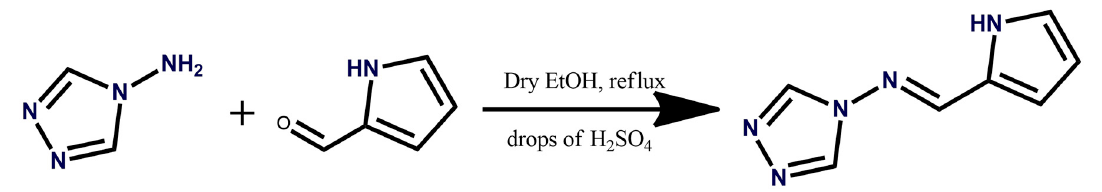
Figure 1. Synthetic scheme to prepare the pyrtrz ligand.